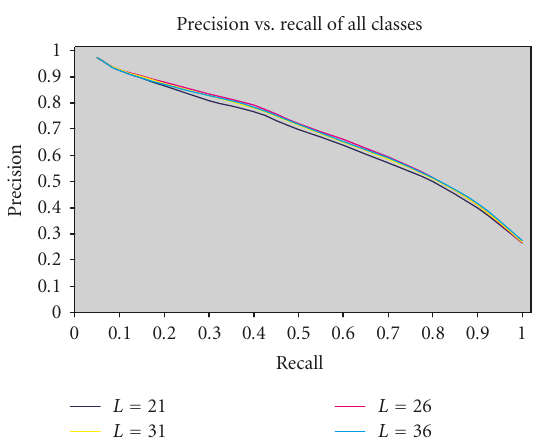
Figure 11: Comparison of the e ffi ciency of RIT-based descriptor vectors using di ff erent dimensionality, in terms of precision-recall diagram using the new